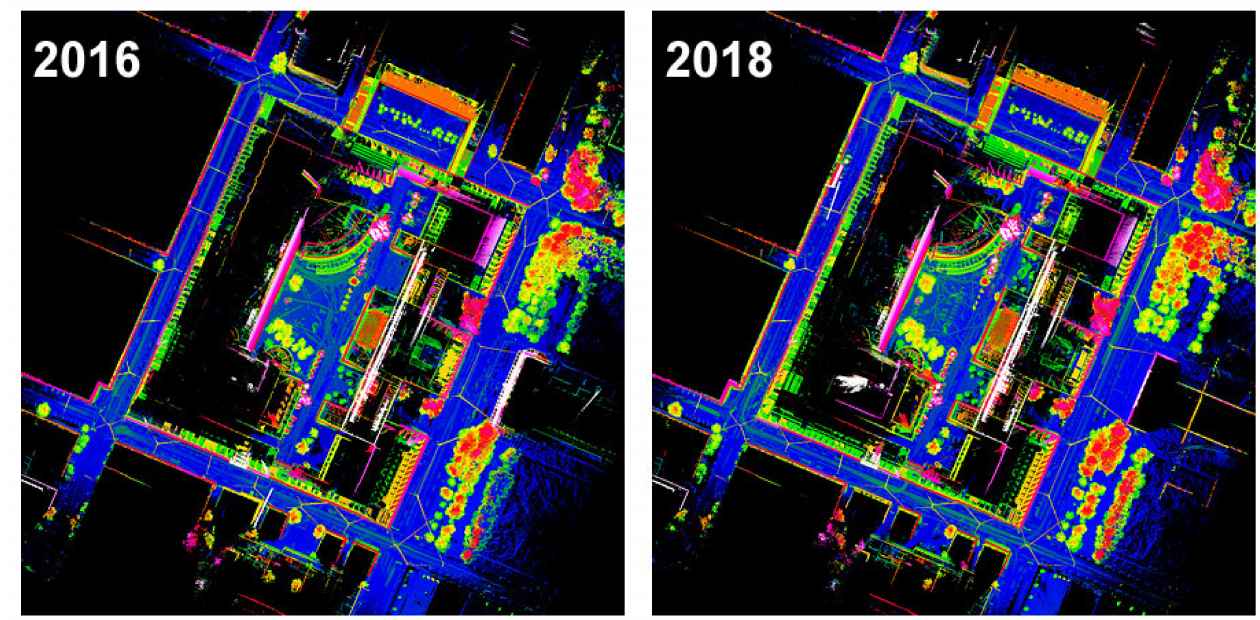
Figure 16. Top views of the dataset TUM-MLS-2016 and TUM-MLS-2018. Color code based on height. Source: Image adopted from